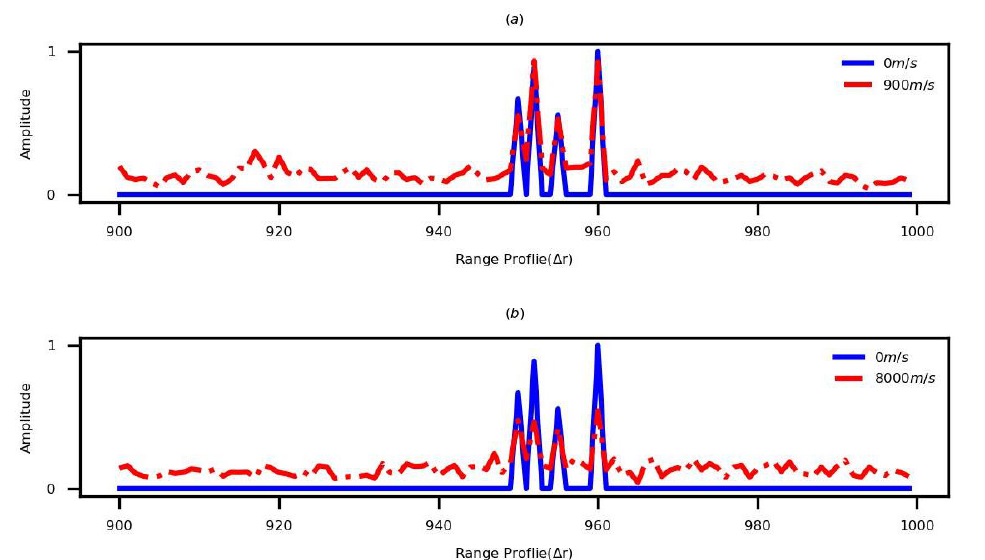
Figure 8. The HRRPs of the stationary noiseless target and the noisy moving target based on different parameter sets. ( a ) Applying the parameter set 1. ( b ) Applying the parameter set